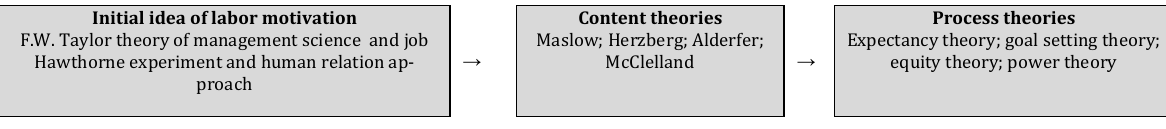
Fig. 2. Systematizing the theories of labor